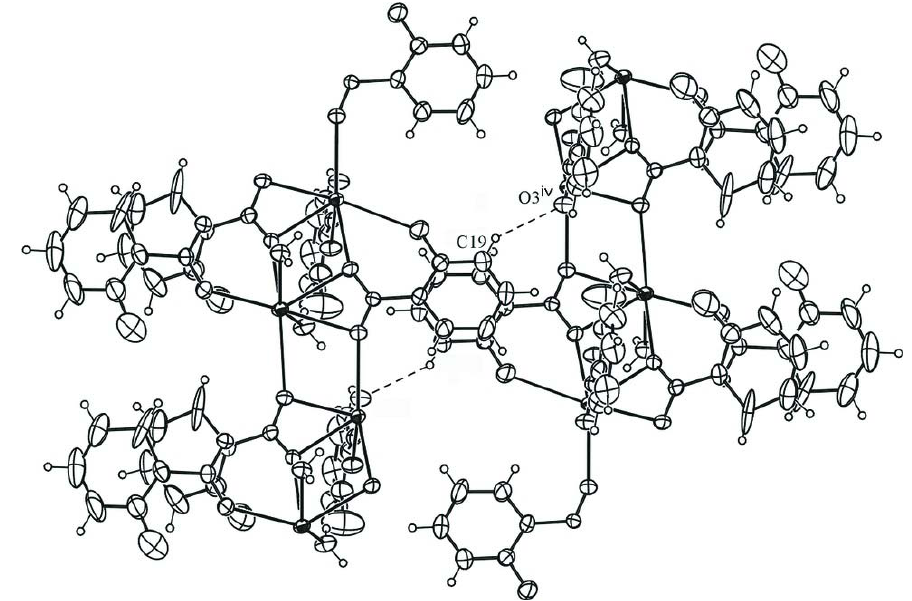
Figure 3 The C—H···O hydrogen bonds (dashed lines) and the π – π stacking interactions in the title compound. [Symmetry code: (iv) - x , - y , 1 - z